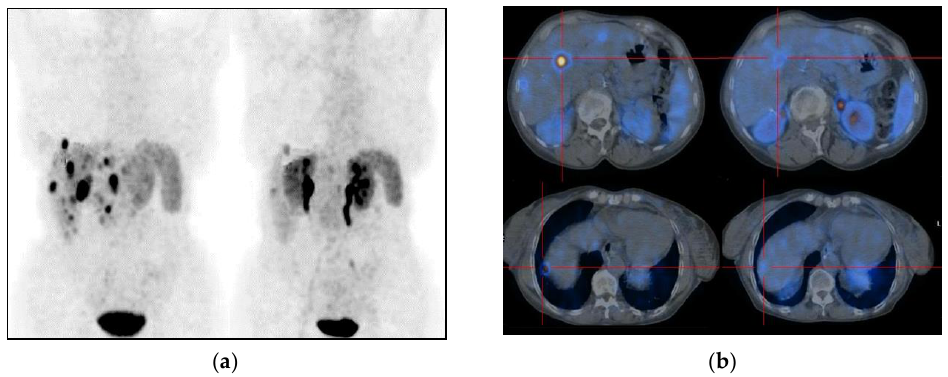
Figure 4. Example of [ 68 Ga]-DOTA-NOC PET/CT before and after treatment with somatostatin analogs in a patient with metastatic ileal neuroendocrine tumors (NET). ( a ) Multi intensity projection (MIP) views of several liver metastases at staging (left) and after treatment (right); ( b ) transaxial images of liver showing the presence of metastasis (left) and their almost complete disappearance after treatment.